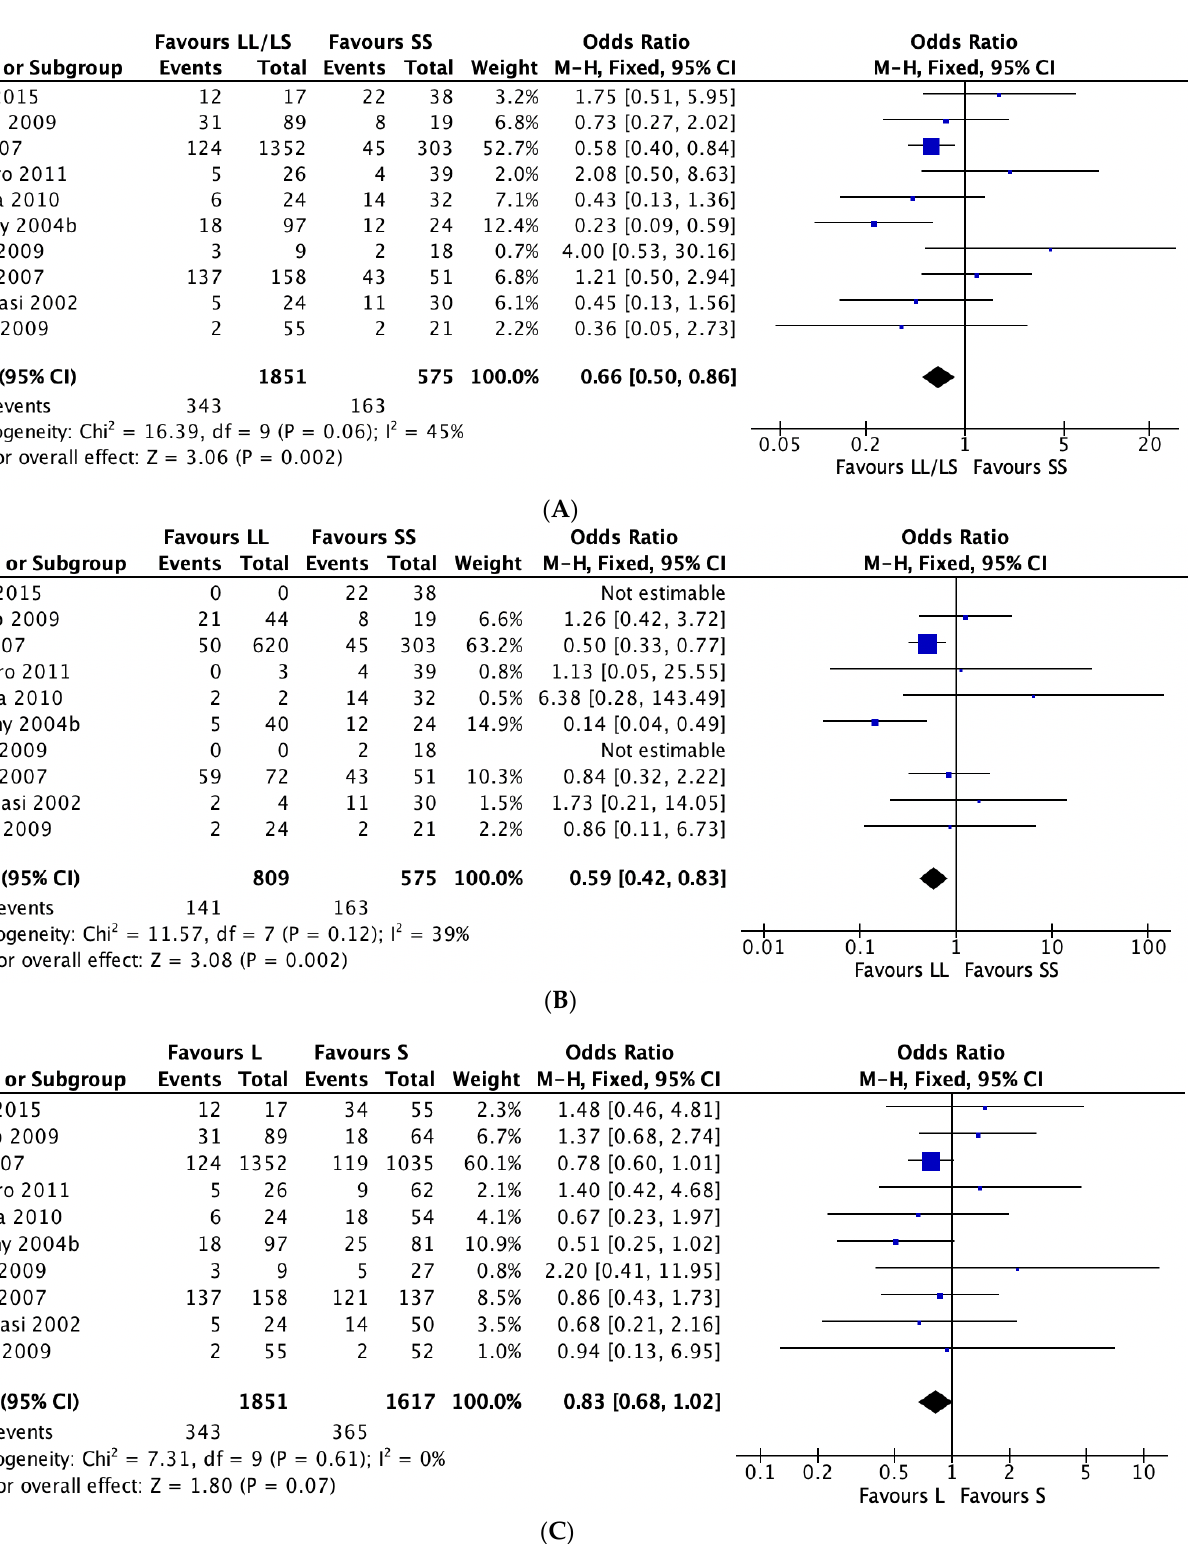
Figure 3. Forest plots of 5-HTTLPR polymorphisms and adverse drug reactions in studies with participants taking SSRIs by genotype comparisons. ( A ) LL/LS vs. SS; ( B ) LL vs. SS; ( C ) L vs. S.